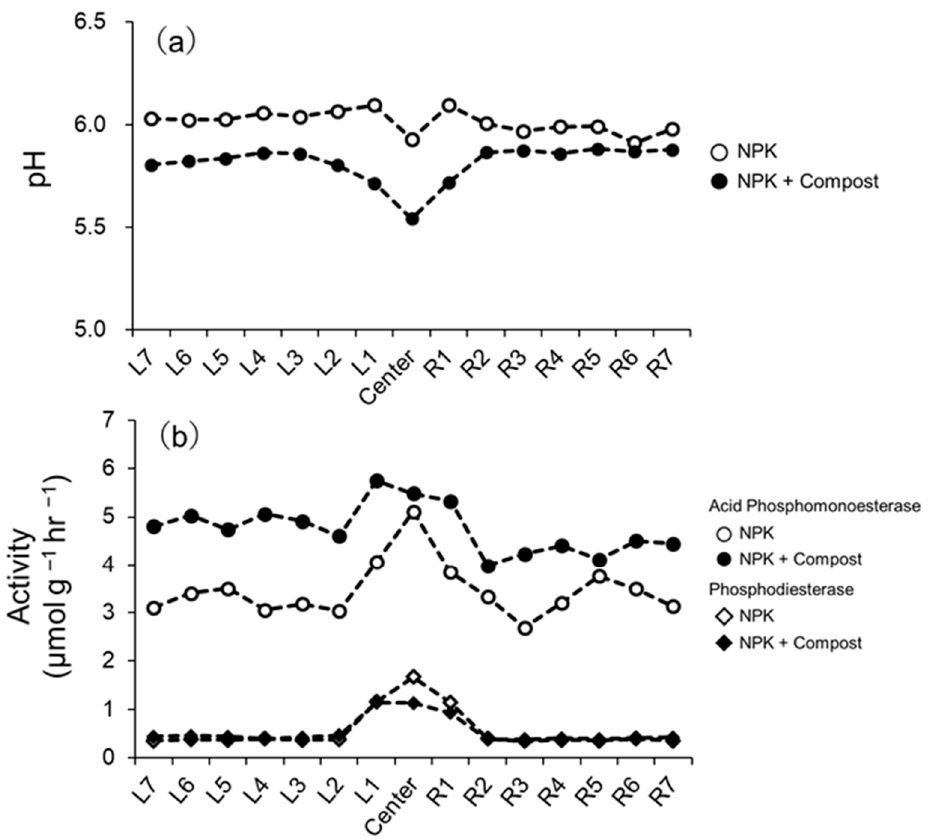
Figure 1. ( a ) Soil pH and ( b ) acid phosphomonoesterase and phosphodiesterase activities in soil compartments collected in 1-mm increments from the root compartment where barley was cultivated for 5 weeks in the rhizobox system.